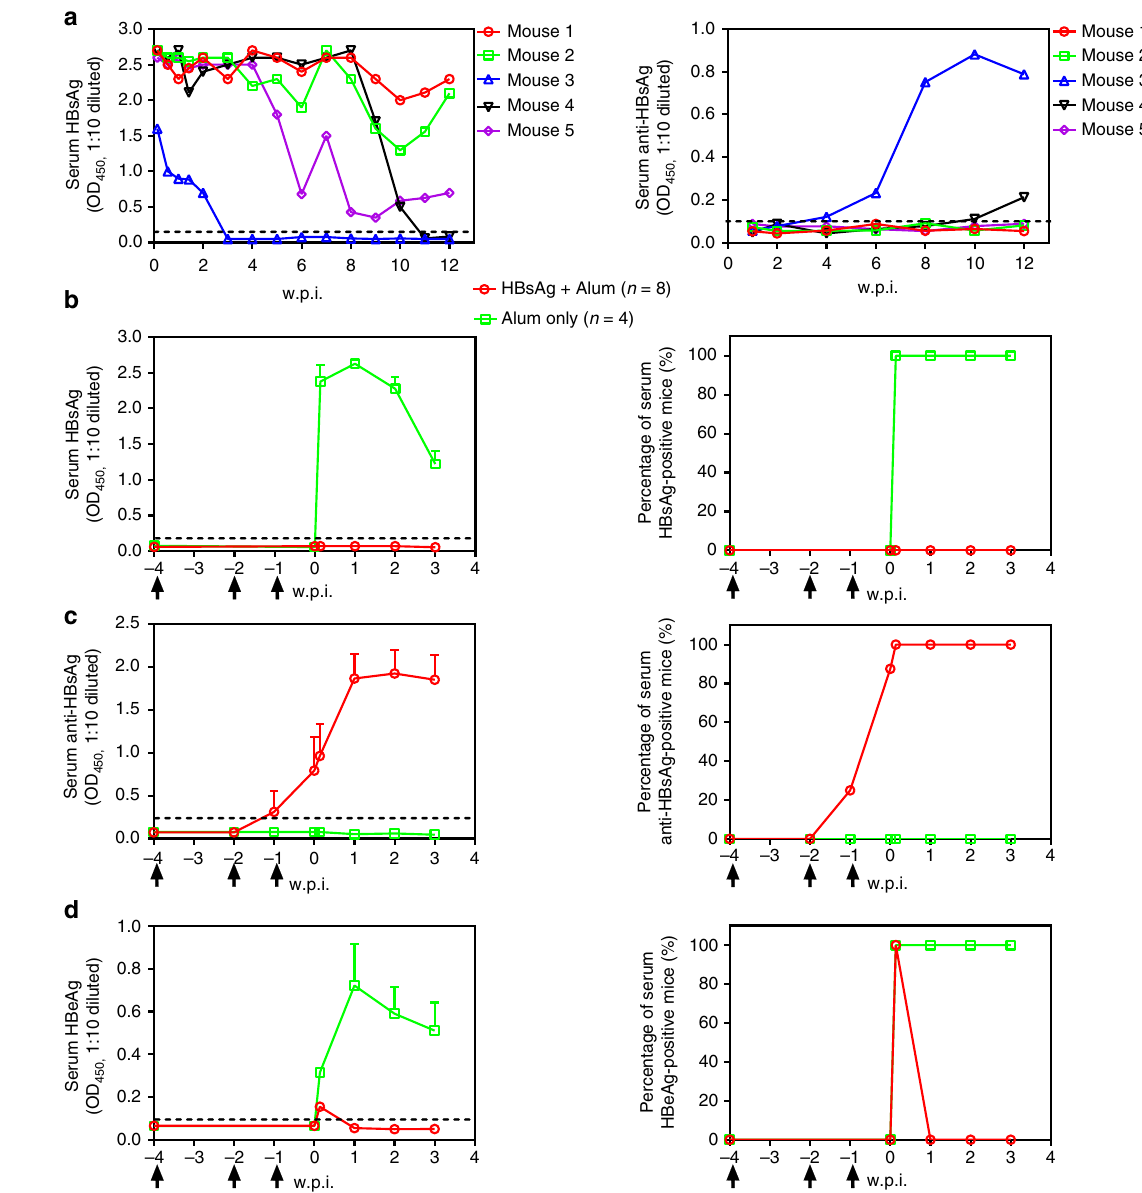
Fig. 4 Relation between autonomous viral clearance in BPS HDI mice and serum HBsAb. a Sera from BPS HDI BALB/c mice were individually analysed for HBsAg (left panel) and HBsAb (right panel) using ELISA. Naive mice were then vaccinated with recombinant HBsAg in three doses at 4, 2 and 1 week(s) (arrows) prior to BPS HDI procedure. Sera were collected at indicated time points and analysed for HBsAg ( b ), HBsAb ( c ) and HBeAg ( d ) using ELISA. Group means and s.e.m. within group are presented with group sizes ( n ) indicated. Dotted lines represent cut-off thresholds. w.p.i. weeks post